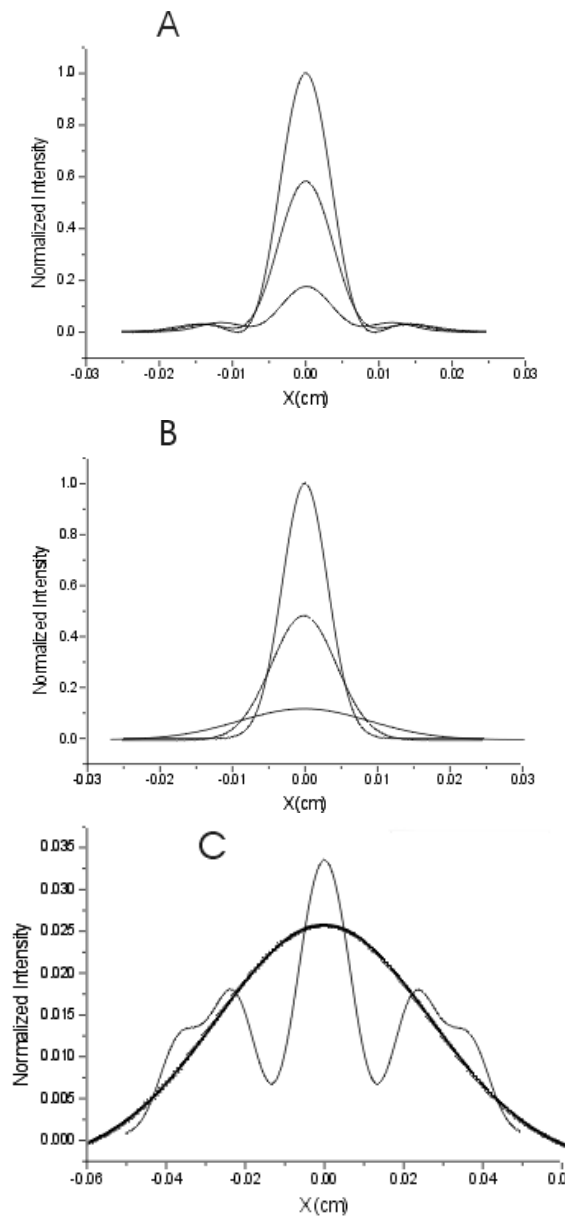
FIG. 11. Simulated transverse intensity distributions for an- nular-shaped and Gaussian CO 2 laser beams focused with the F (cid:1) 15 cm lens: (a) annular-shaped beam at the focal plane (cid:4) s (cid:1) 32 m m (cid:5) and at distances of 1.2 and 3.5 mm from the fo- cal plane; (b) the same as in (a) but for the Gaussian laser beam; (c) comparison of the annular and Gaussian beams at the 7 mm distance from the focal